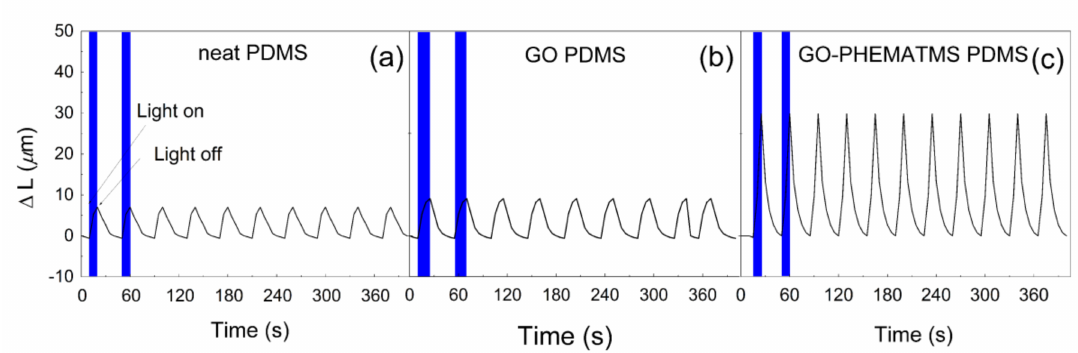
Figure 8. Light-induced deformation capability of pure PDMS ( a ), PDMS composites containing 0.1 vol % of GO ( b ), and GO–PHEMATMS ( c ) under the application of irradiation, with an intensity of 6